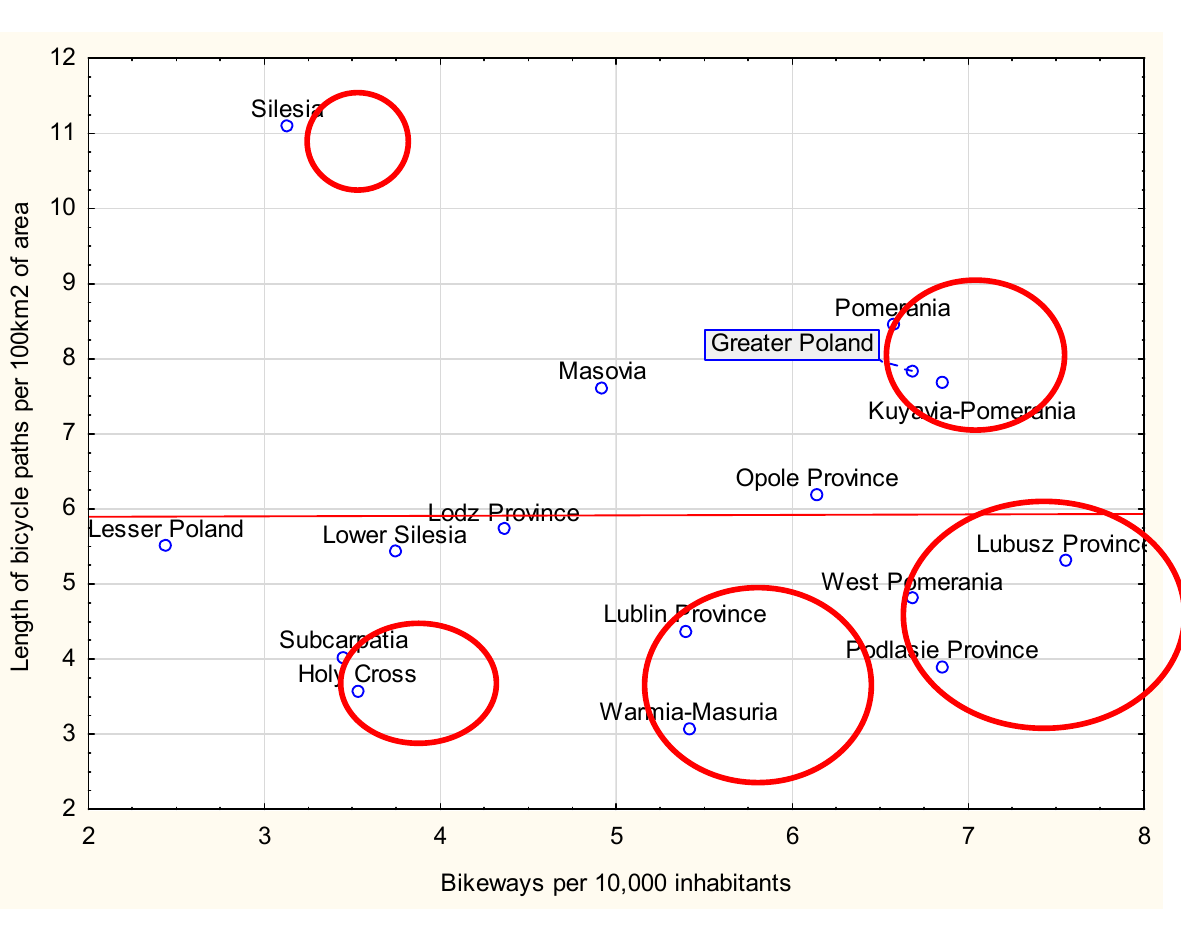
Figure 8. Relationship between the length of bicycle paths per 100 km 2 of area in a province and the length of bicycle paths per 10,000 inhabitants in that province. Source: Author own analysis.